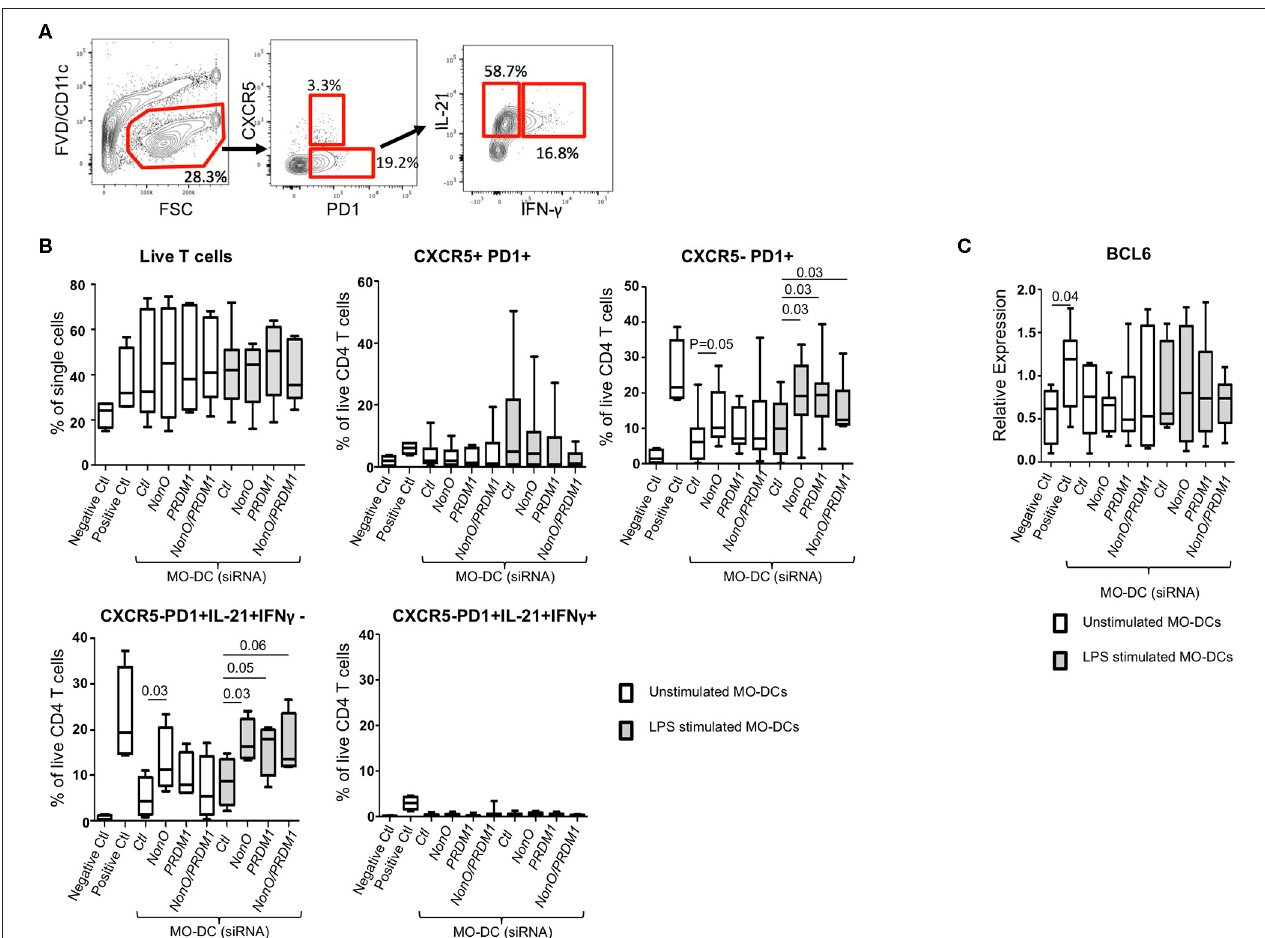
FIGURE 5 | PRDM1- or NonO-deficient MO-DCs induce increased T FH differentiation. Allogenic culture of naïve CD4 + T cells and MO-DCs was set up to induce T FH differentiation. Expression levels of PRDM1 or NONO in MO-DCs were modulated by transfection with siRNAs before co-culture. After 6-days culture, T FH cell differentiation was measured by IL-21, IFN γ , CXCR5, and PD1 expression by flow cytometry. (A) A representative flow image. (B) Dead cells were excluded using Fixable Viability Dye eFluor 506, and the percentage of live CD4 + T cells was calculated. T FH -like cells (CXCR5 + /PD1 + ), CXCR5- helper T cells (CXCR5-/PD1 + ), and cytokine expressing helper T cells (CXCR5-/PD1 + / IL21 + / IFN- γ -, and CXCR5-/PD1 + /IL21 + / IFN- γ + ) were calculated and plotted. Co-culture of T cells with LPS pre-stimulated MO-DCs was indicated with gray filled box and culture with unstipulated MO-DCs was indicated with open box. Negative control is naïve CD4 + T cell alone and Positive control is naïve CD4 + T cells with CD2/3/28 activation beads IL-6 (50ng/ml) and IL-12 (20ng/ml). In the Box-and-Whisker plot, horizontal bars indicate the median, boxes indicate 25–75th percentile, and the whiskers indicate 10 and 90th percentile. Four independent experiments ( n = 9). Significance determined by Mann Whitney test. (C) BCL6 expression was quantified by qRT-PCR. Relative expression was calculated to the level of housekeeping gene, POLR2A . In the Box-and-Whisker plot, horizontal bars indicate the median, boxes indicate 25–75th percentile, and the whiskers indicate 10 and 90th percentile.